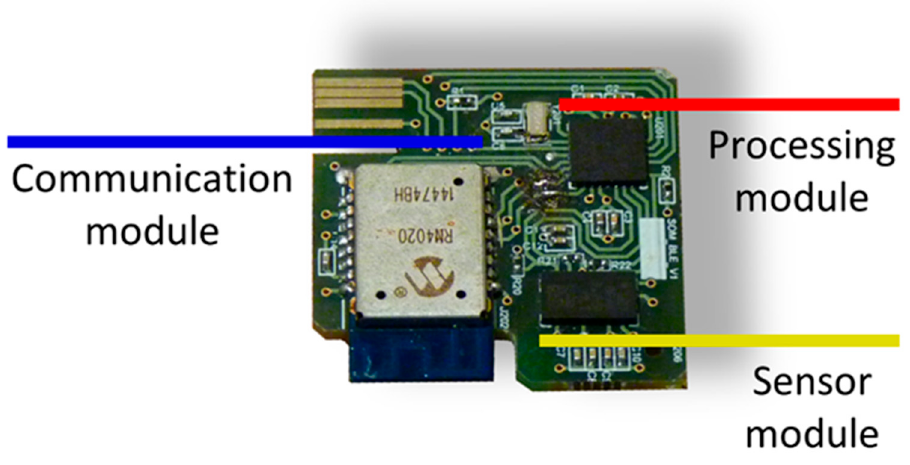
Figure 3. Impact detection device hardware.